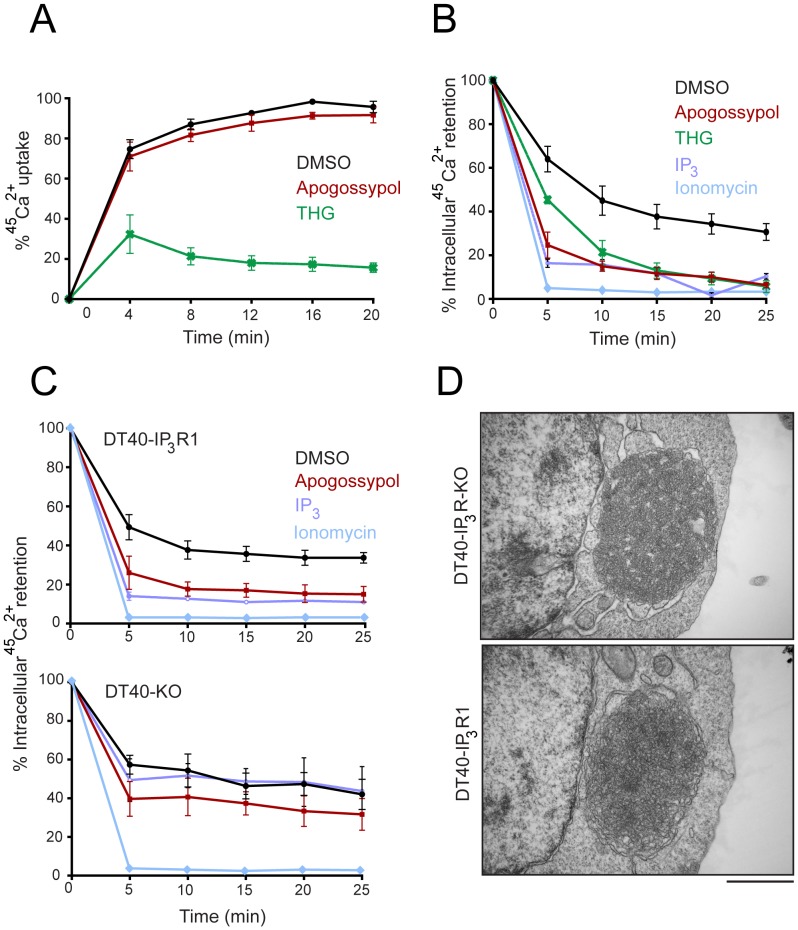
Apogossypol-induced ER membrane reorganization is not due to depletion of intracellular Ca2+ stores.(A) Permeabilized HeLa cells, exposed to DMSO (control), apogossypol (10 µM), or THG (10 µM), were labelled with 45Ca2+ and samples collected at the indicated times to assess 45Ca2+ uptake. (B) Permeabilized HeLa cells labelled with 45Ca2+ for 20 minutes, were exposed to DMSO (control), apogossypol (10 µM), THG (10 µM), IP3 (3 µM) or ionomycin (1 µM) for the indicated times and samples collected and assessed for the extent of 45Ca2+ release. (C) Experiments were carried out as in (B) except using DT40 cells, that either lack all 3 isoforms of IP3 receptors (DT40 KO) or were reconstituted with IP3R1 (DT40-IP3R1). (D) Extensive ER membrane reorganization, as assessed by electron microscopy (scale bar, 1 µm) was observed in DT40- IP3R1 and DT40 KO cells, exposed to apogossypol (10 µM) for 4 h. Error bars shown in A–C represent the standard error of the mean.